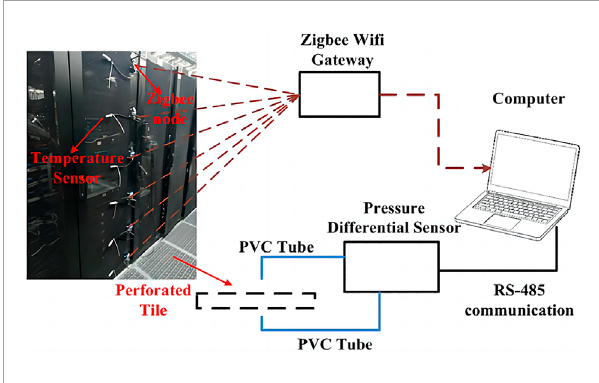
FIGURE 4 The framework of the temperature and pressure differential monitoring